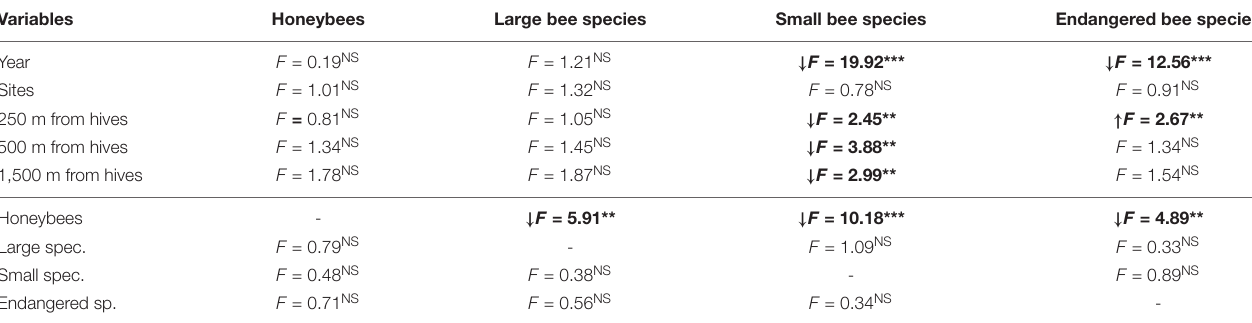
Arrows before value show the direction of main effects: ↑ indicates a positive relationship, and ↓ indicates a negative relationship. “-” shows where a term was not retained in the minimum adequate model. ***P < 0.001, **P < 0.01, NS denotes not